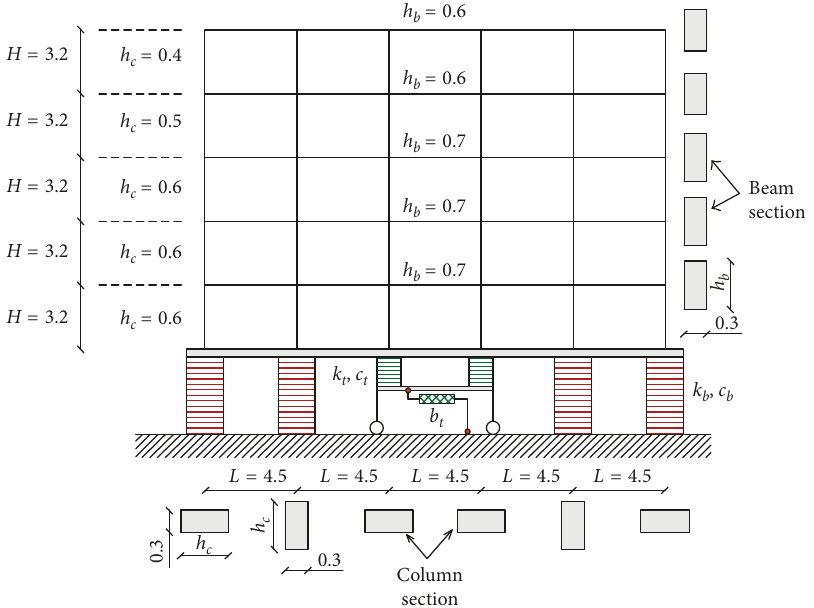
Figure 14: Five-story RC building with the seismic protection system proposed in this paper (all dimensions in